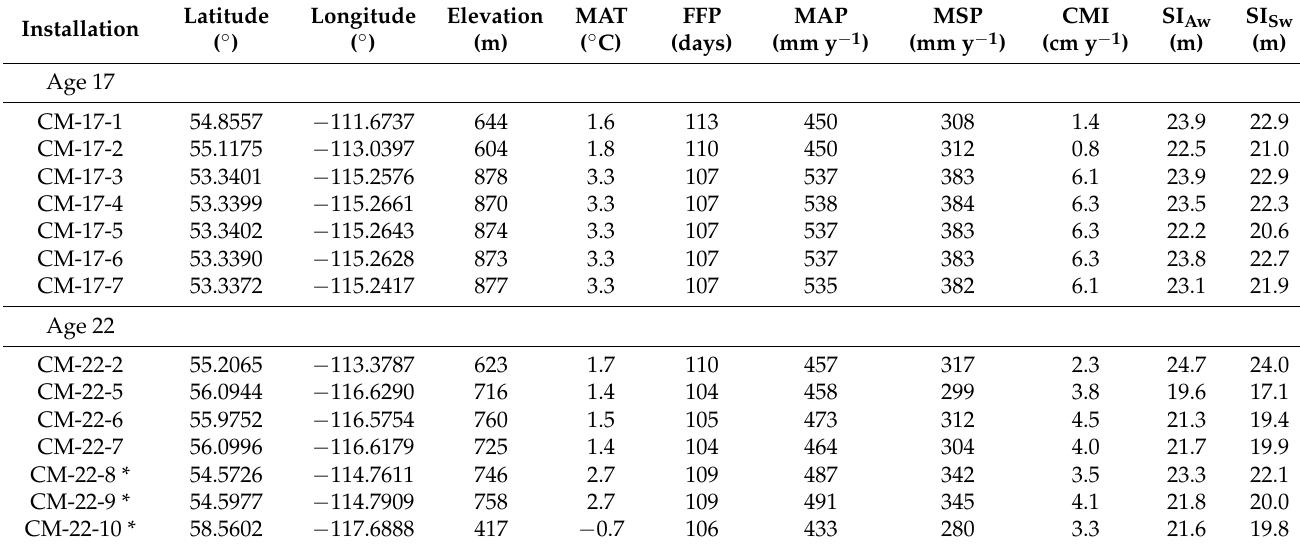
Table 1. Study site (installation) information and characteristics. Treatment age represents stand age in the year of thinning and refers to years after harvest. Climate information represents means for the 1985–2018 period obtained from ClimateNA v6.11 [21]. MAT = Mean Annual Temperature; FFP = Frost Free Period; MAP = Mean Annual Precipitation; MSP = Mean Summer Precipitation; CMI = Climate Moisture Index (Hogg et al. 2013). SI aw = Site Index for aspen, calculated as an average of Site index for 4 aspen dominated treatment plots at the installation, and represents tree height at a reference age of 50 years total age; SI sw = Site Index for white spruce obtained using an aspen-to-spruce SI conversion model